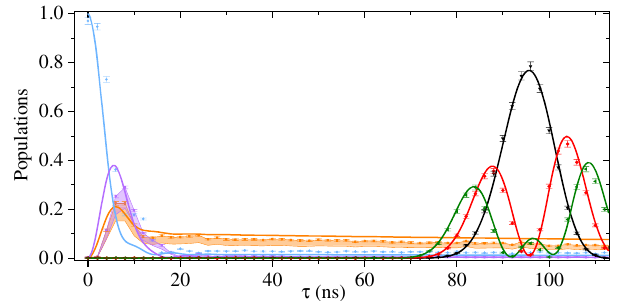
FIG. 3. Circular state preparation with a square pulse. Evolu- tion of the population P j ð τ Þ of the levels labeled by j ( j ¼ m 1 , m m e e c , where the labels and the associated color 2 , 3 , 2 , 1 , and code are defined in Fig. 1) as a function of the duration τ of the rf pulse. The points are experimental with statistical error bars. The shaded areas (purple and orange) shows the error range for levels m m 1 and 3 due to the uncertainty on the MW probe pulses calibration (see Appendix C). The solid lines correspond to the numerical simulation of the